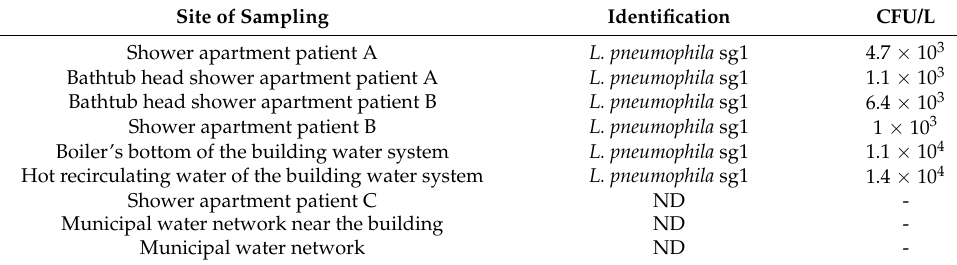
Table 1. Legionella pneumophila concentration in the different sampling